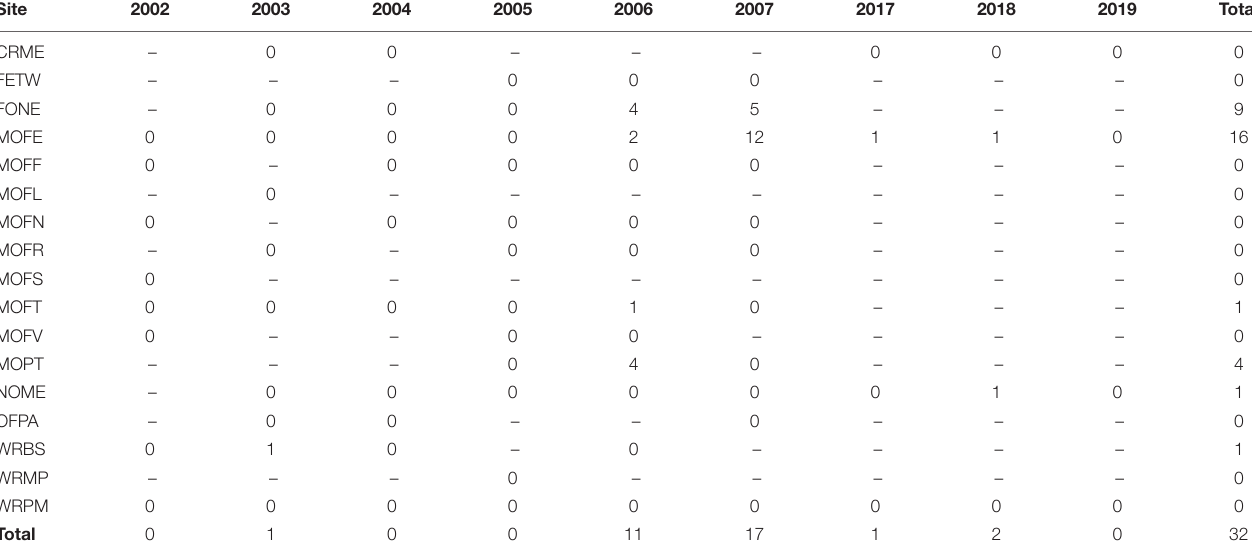
TABLE 6 | Hatch-year dickcissel captures by site and year.